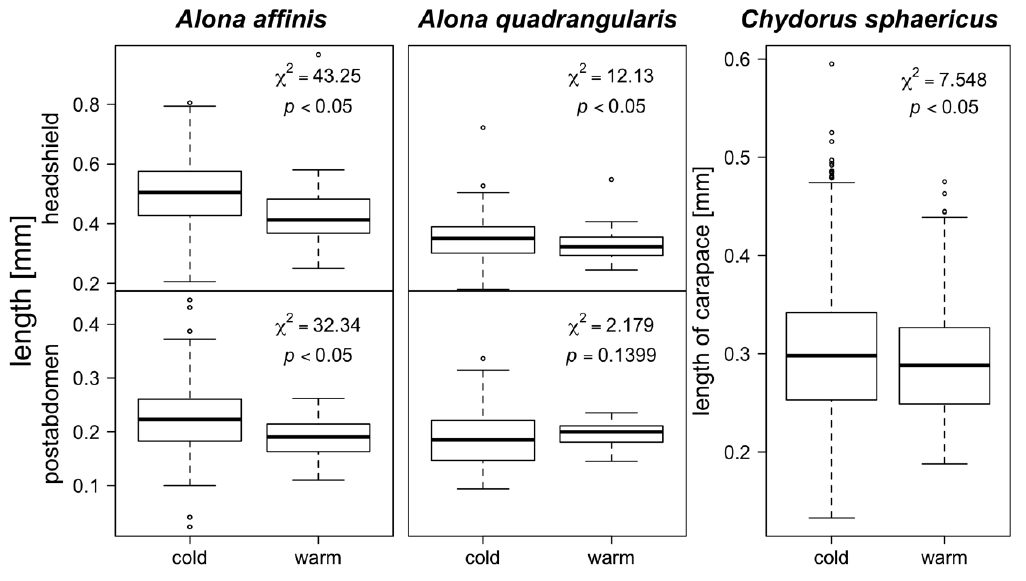
Figure 3. Differences in length of headshields and postabdomens of the Alona species and carapaces of Chydorus sphaericus by temperature regions.